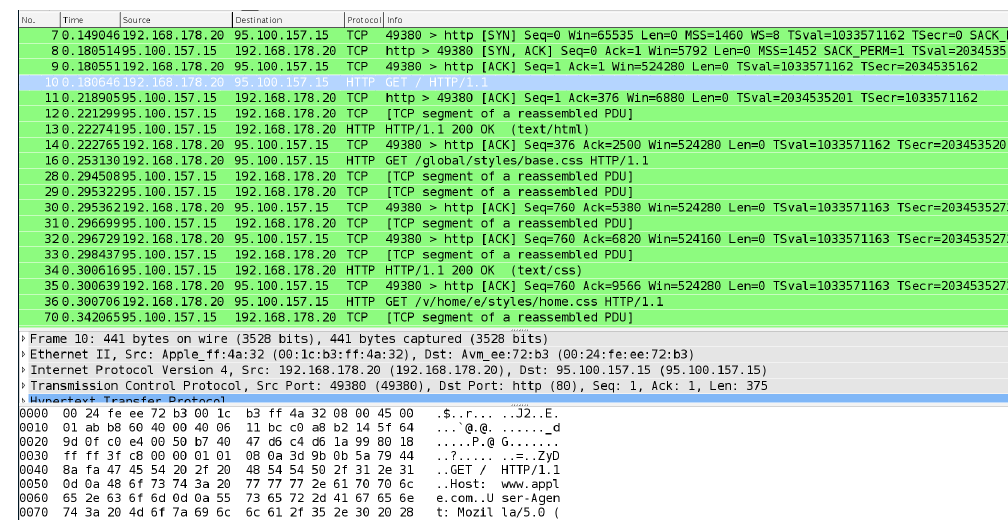
Figure 3. Network Packets of a Direct Web